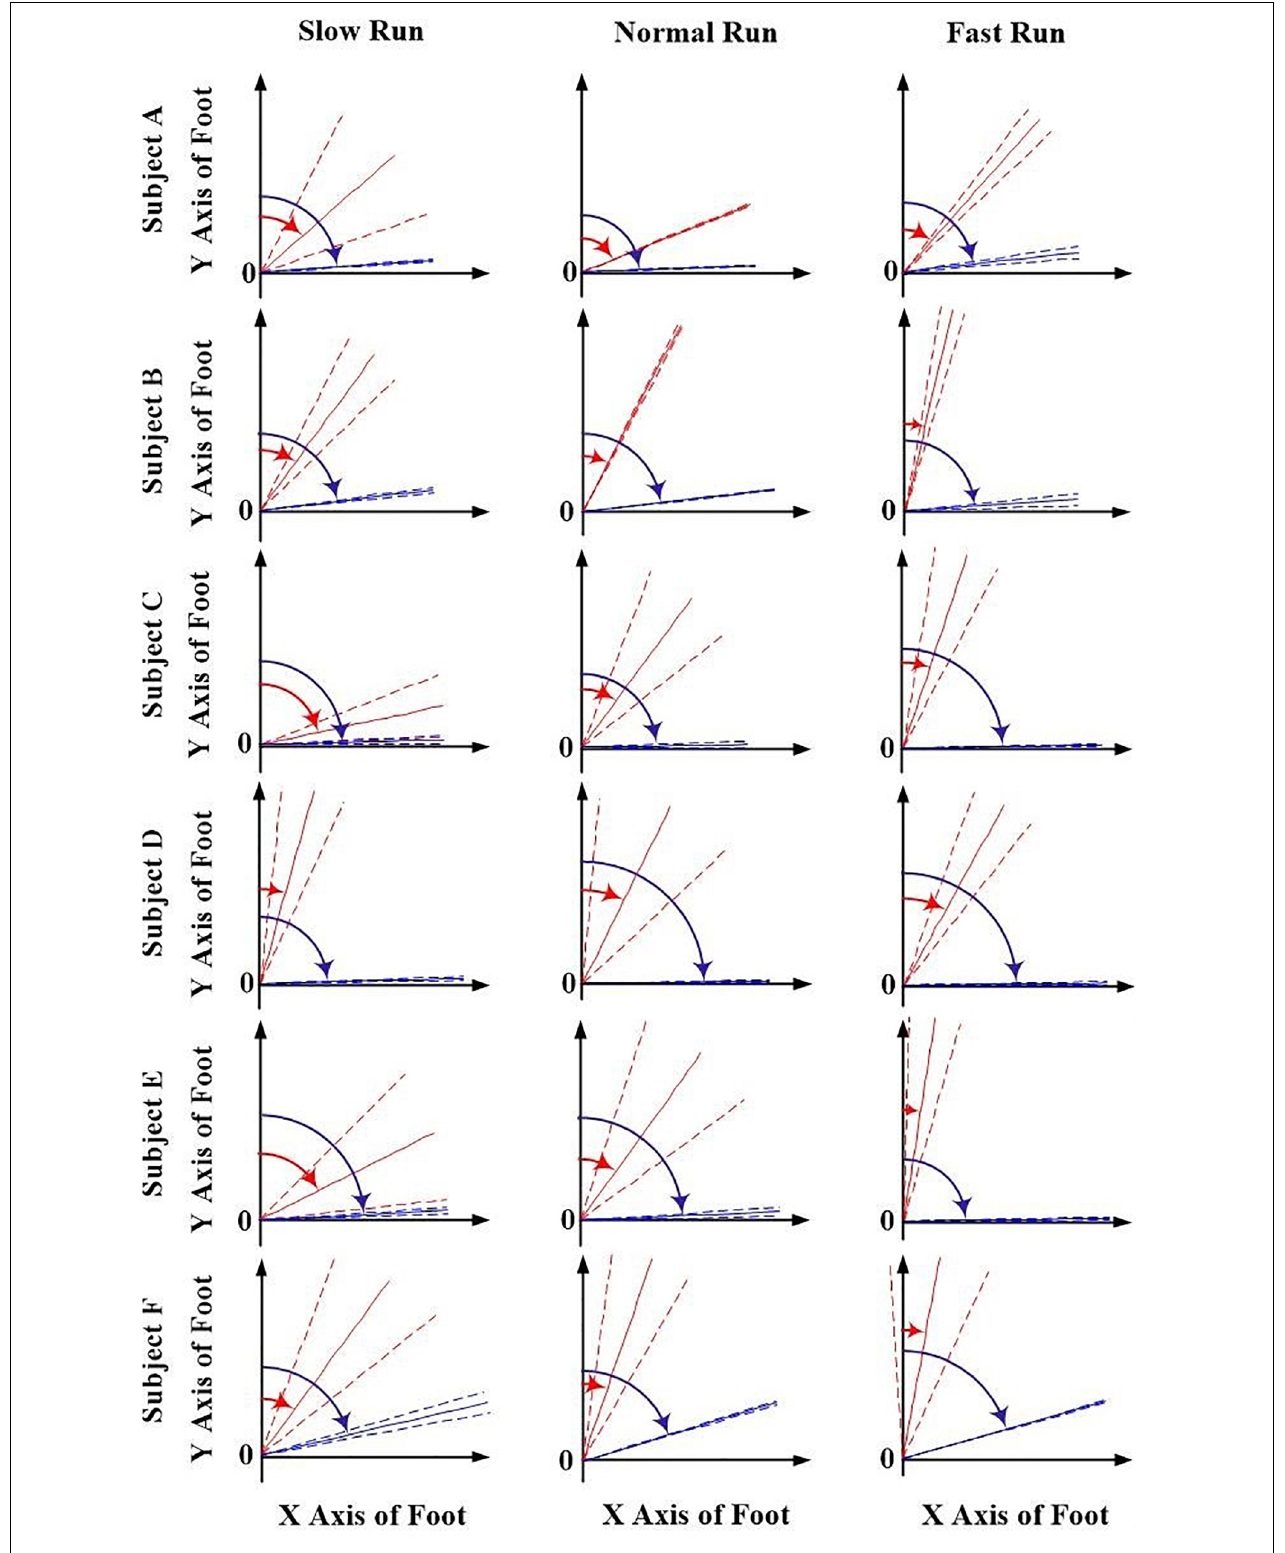
FIGURE 4 | The orientation angle β made by the anatomical axis (blue) and functional axis (red) for all the six subjects (A–F) and across all the three speeds of running (slow, normal, fast). Solid lines depict mean; dashed lines depict the 1 SD zones.